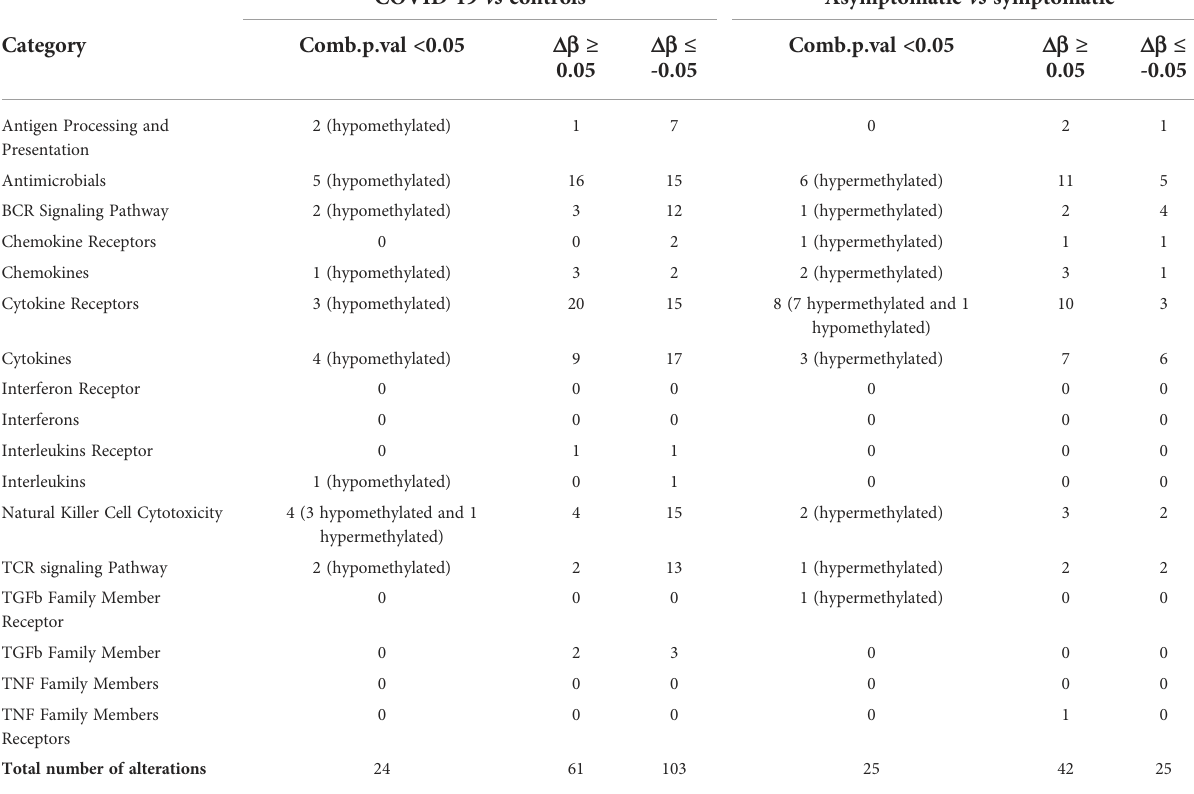
TABLE 1 Differentially methylated CpG islands in COVID-19 patients vs controls and asymptomatic vs symptomatic COVID-19